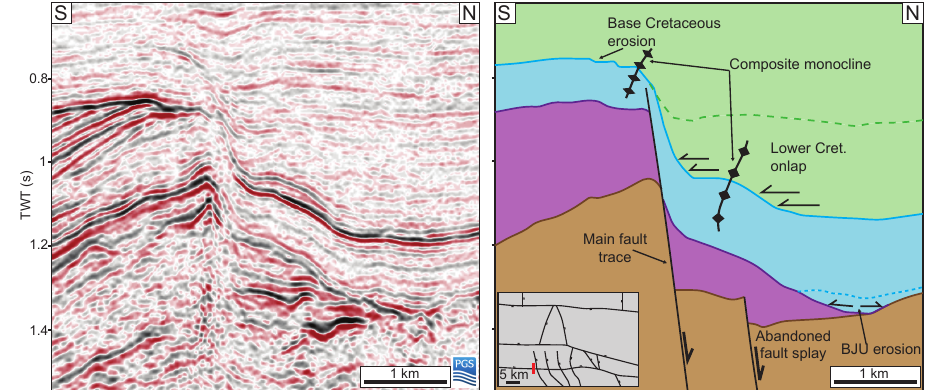
Figure 14. Interpreted and uninterpreted N–S-oriented seismic section (from 3-D seismic volume) across the Fjerritslev south fault. The section shows the presence of a composite monocline and associated underlying relay ramp.